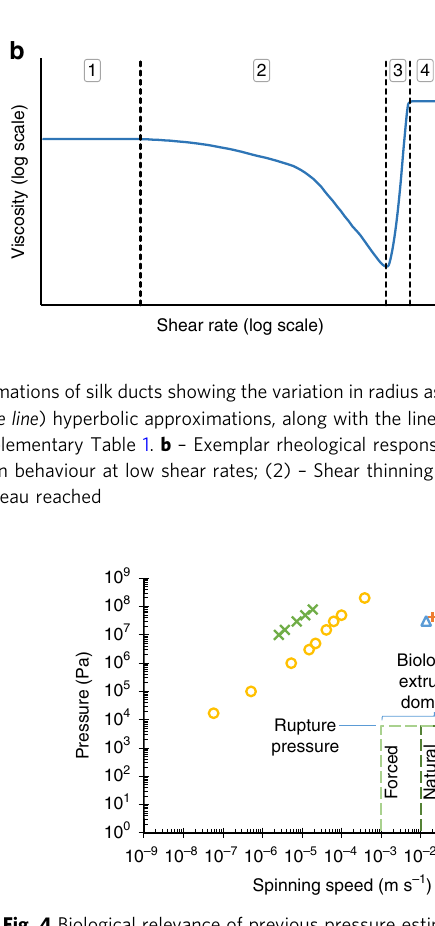
Fig. 3 Variation in wild and domesticated silkworm feedstock viscosities. Measured values of the low shear viscosity of wild ( circles ) and studies 4, 33, 37, 40, 54, 55, 57, 58, 73 – 75 , the highlighted regions show the mean